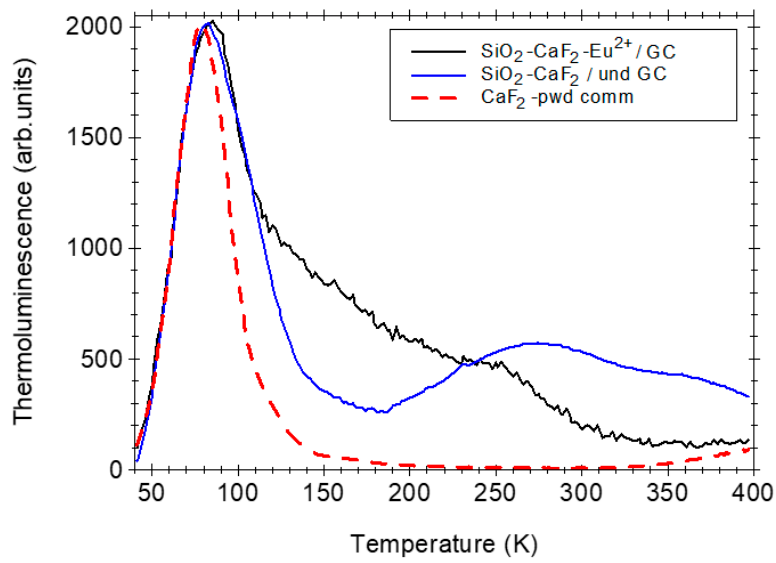
Figure 8. Normalized thermoluminescence curves recorded in Eu 3+ -doped SiO 2 -CaF 2 glass-ceramics annealed in reducing atmosphere compared to those recorded in un-doped glass-ceramics annealed in air and CaF 2 commercial crystalline powder.